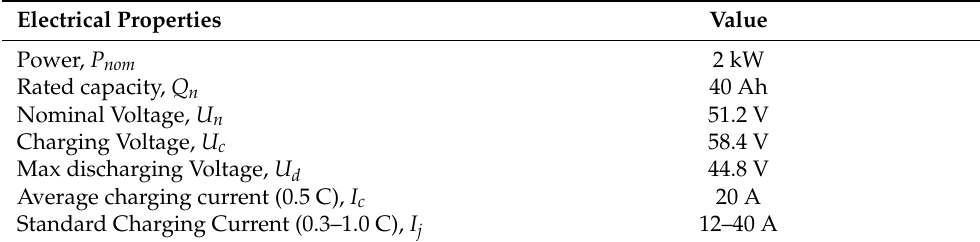
Table 1. Technical characteristics of the EV battery.